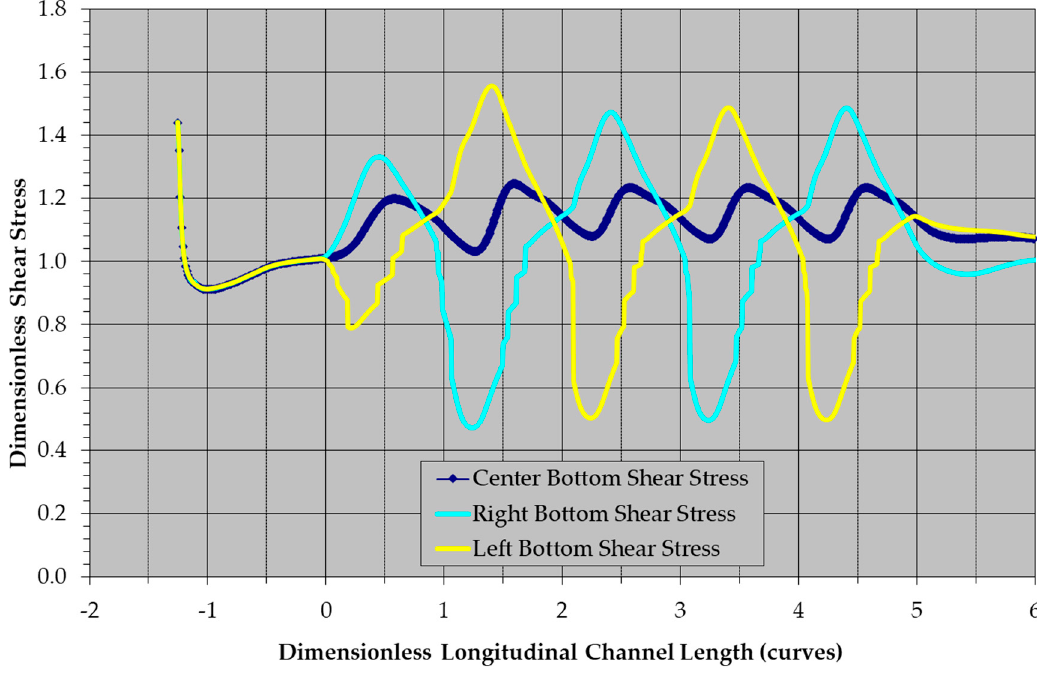
Figure 42. Dimensionless shear stress along the channel centerline, left and right banks for Simulation Set 8 with a sinuosity of 2.00 and a width/depth ratio of 9.1.